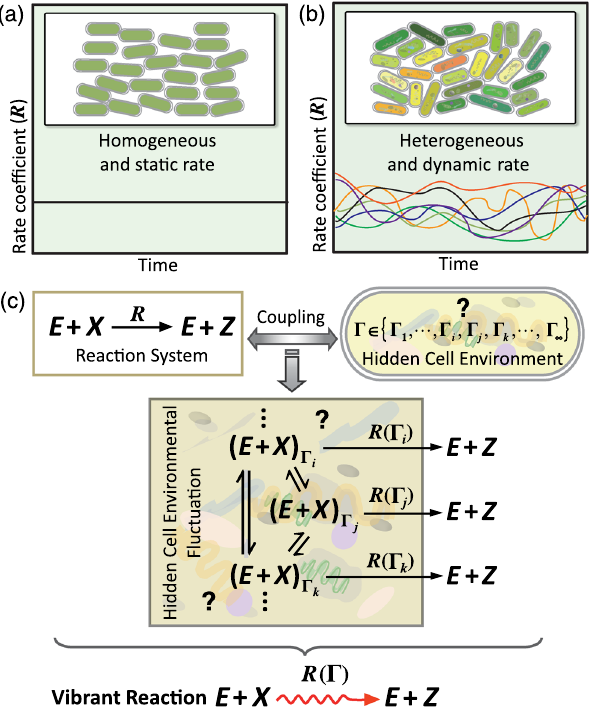
FIG. 1. Concept of vibrant reaction process coupled to complex and hidden cell environment. Schematic representa- tions of (a) an elementary reaction process under a homo- geneous environment and (b) a vibrant reaction process with the rate coefficient being a stochastic variable that differs from cell to cell and fluctuates over time (Fig. 1 of Supplemental Material [32]). (c) Coupling of a reaction system to a complex and hidden cell environment makes the rate-coefficient sto- chastic variable dependent on the cell environmental state, the correct, explicit model of which cannot be easily constructed for lack of available information. A reaction process whose rate coefficient is coupled to hidden environment will be designated by vibrant reaction process and represented by the wavy